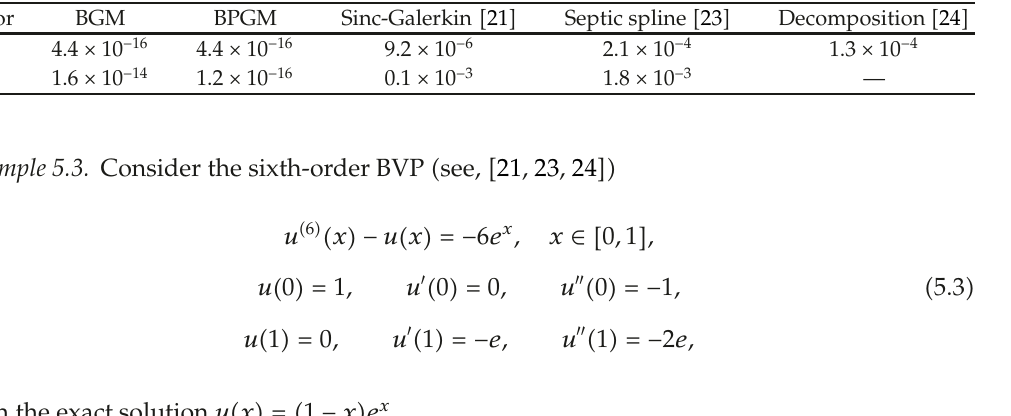
Table 5: Comparison between the errors of di ff erent methods in Example